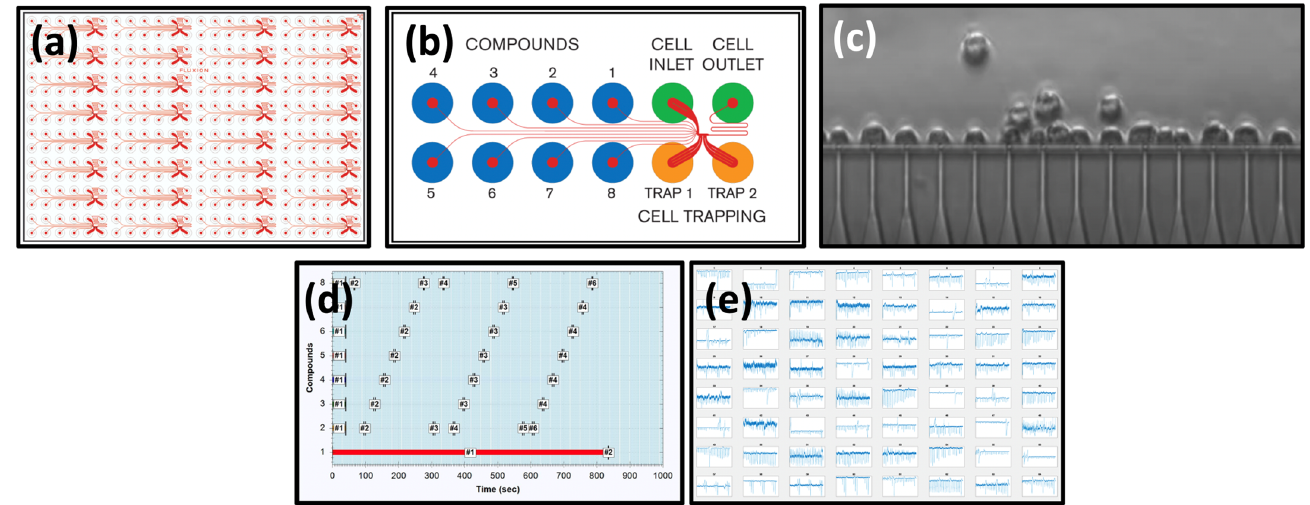
Figure 1. Microfluidic experimental layout. ( a ) A 384-well HT Mercury plate layout showing 32 repeats of the same perfusion system. The orange color depicts the 12 wells and the microfluidic channels connecting them. ( b ) Single experimental pattern and microfluidic channels. Compounds are loaded into wells 1–8 (blue), cells are loaded into the inlet and intracellular solutions in the 2 traps well (orange). ( c ) Fourteen HEK293 cells trapped prior to whole cell seal formation. ( d ) Eight compounds and nine dose response protocols. ( e ) Representative data file with 192 dose responses collected in 15